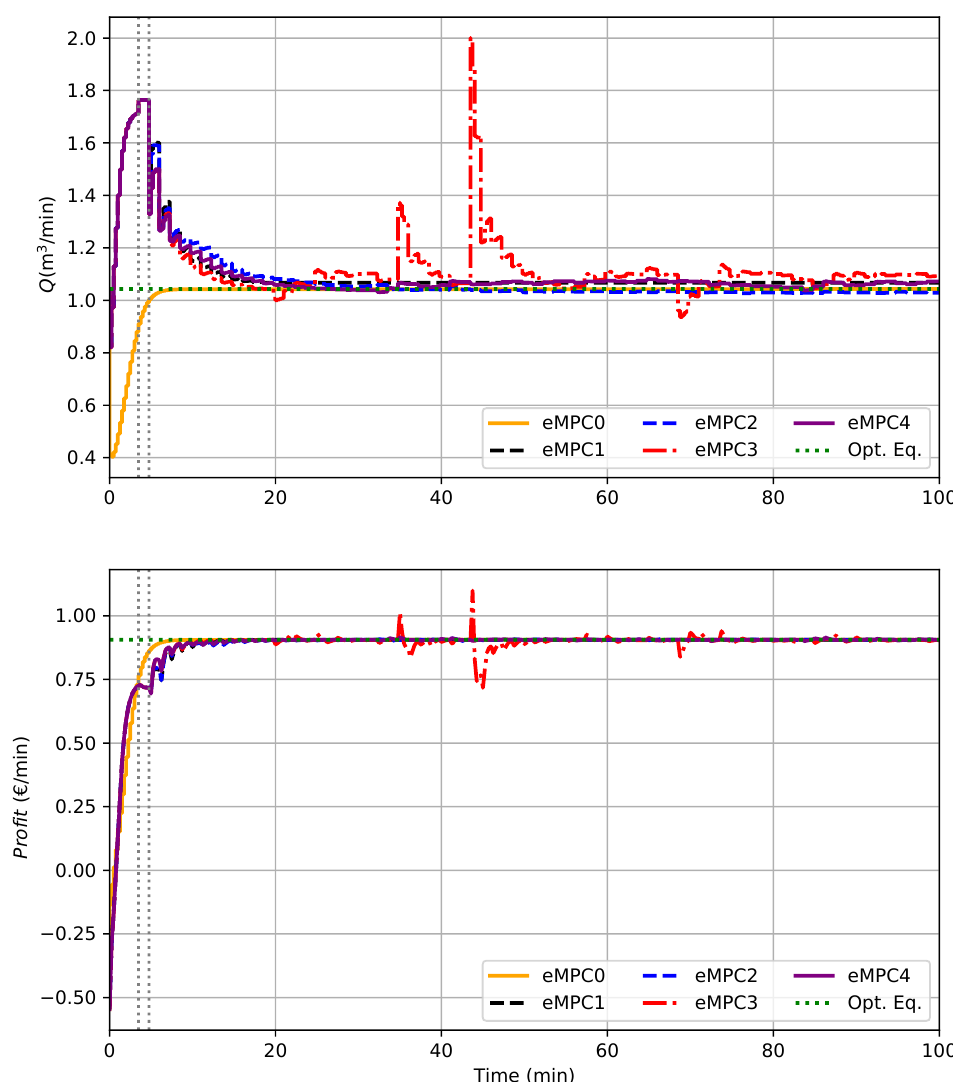
Figure 4. Reactor performance with five controllers and M = 5: input ( top ) and profit ( bottom ). The dotted vertical lines depict the time interval [3.75–5] min used for Λ